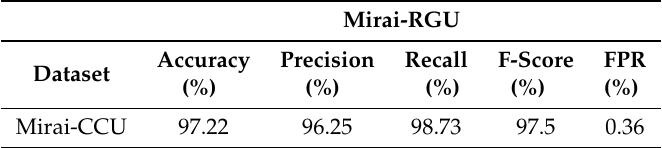
Table 11. Performance evaluation results of the Mirai-CCU dataset validation on the Mirai-RGU training